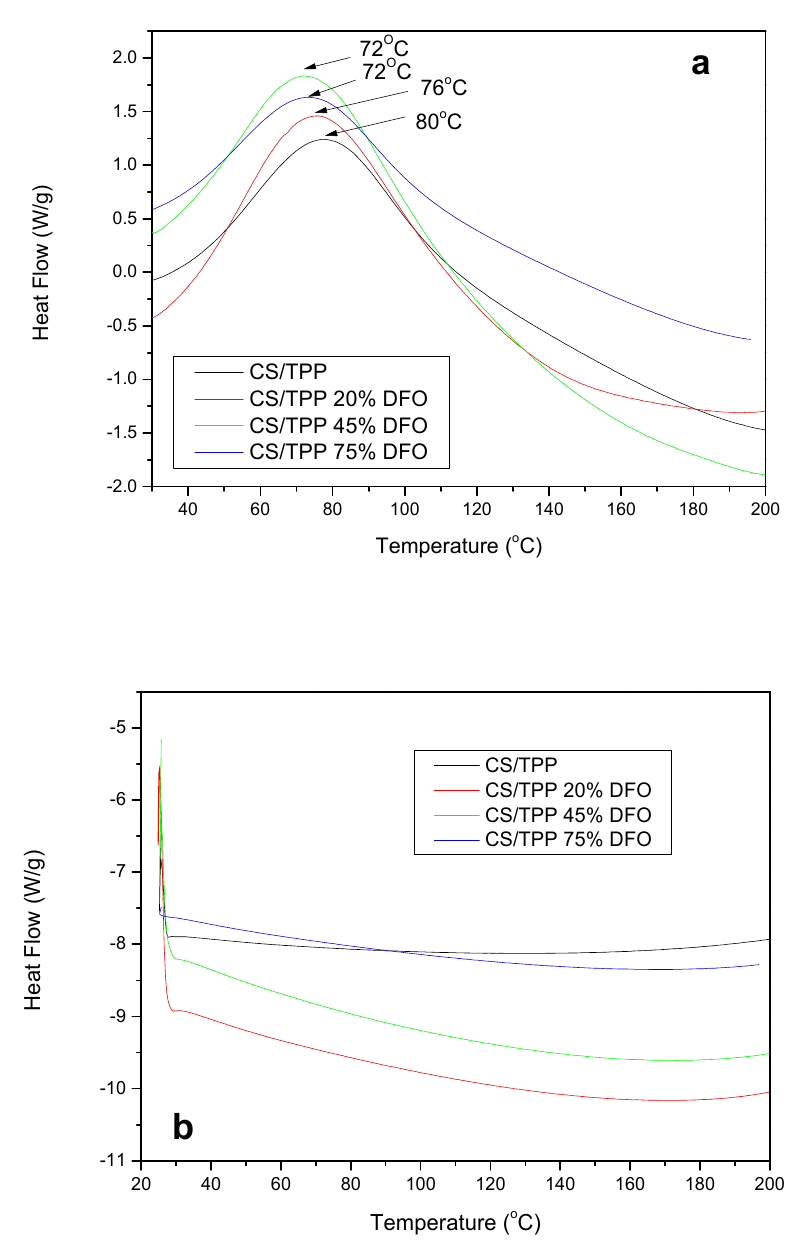
Figure 7. DSC thermograms of CS/TPP and their nanoparticles containing different amounts of DFO. ( a ) First heating and ( b ) second heating.